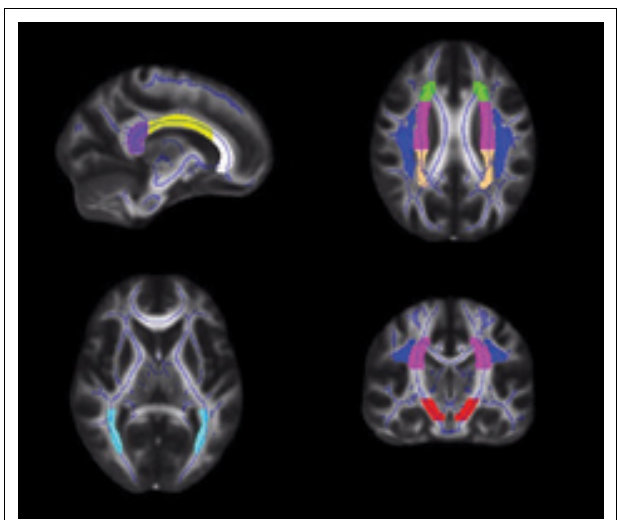
FIGURE 1 | Illustrations of the white matter tract ROIs in the corpus callosum (white = genu; yellow = body; purple = splenium), corona radiata (anterior = green; superior = pink; posterior = peach), superior longitudinal fasciculus (blue), posterior thalamic radiation (light blue), and cerebral peduncle